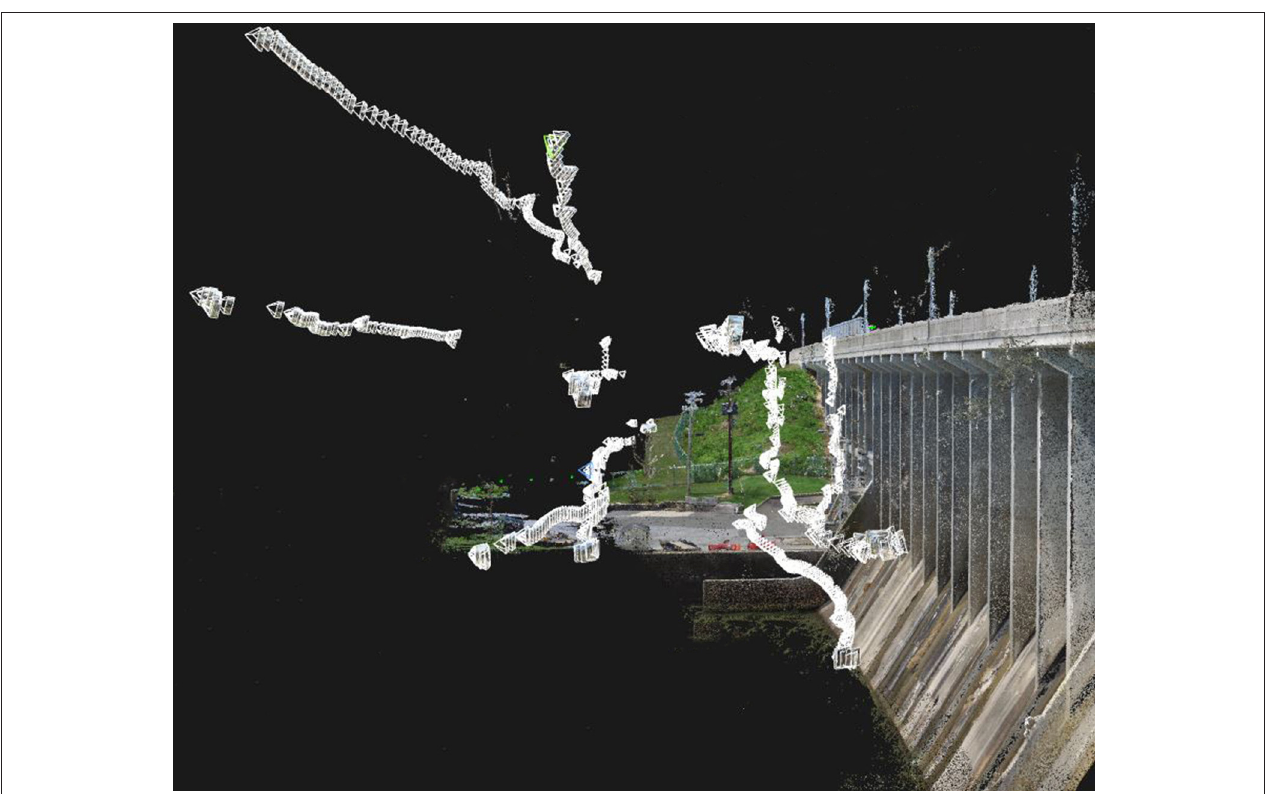
FIGURE 4 | Camera poses using oblique imagery dataset captured by rotary UAVs (downstream face).